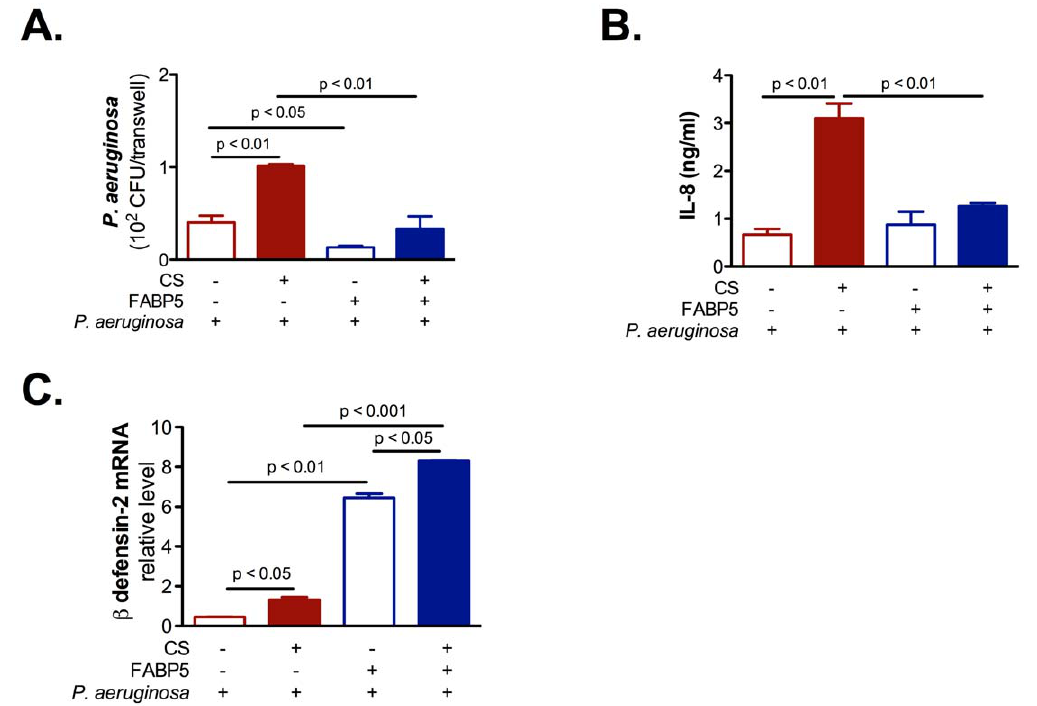
Figure 5. FABP5 overexpression decreases inflammation and increases innate immunity in primary NHBE cells. A. CS exposure decreases P. aeruginosa colony forming units (CFU) on primary NHBE cells overexpressing FABP5. B. FABP5 overexpression blocks CS-induced IL-8 secretion in the basolateral supernatant of primary NHBE cell cultures. C. FABP5 overexpression augments b -defensin 2 mRNA expression in primary NHBE cells. FABP5 2 indicates cells overexpressing GFP and FABP5 + indicates cells overexpressing FABP5. Data are representative of 3 independent experiments and are expressed as mean 6 SEM.